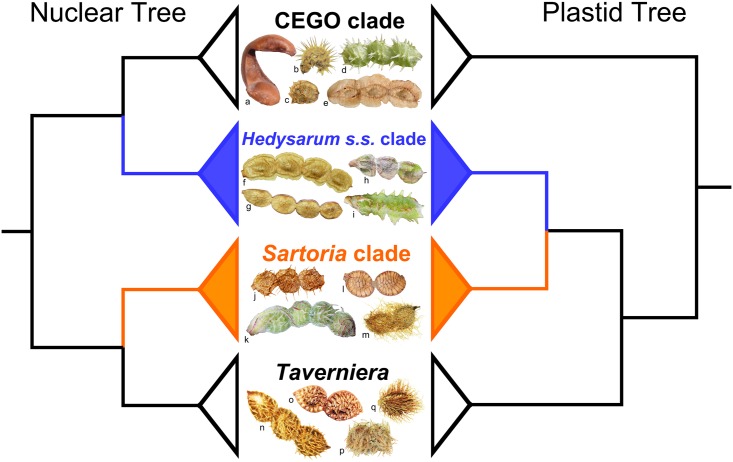
Summary of the incongruent position of the Hedysarum s.s. clade in the nuclear (left) and the plastid (right) trees, with selected legume species from each clade (middle).The legumes: a, Eversmannia subspinosa B.Fedtsch.; b, Onobrychis atropatana Boiss.; c, O. viciifolia Scop.; d, Corethrodendron multijugum (Maxim.) B.H.Choi & H.Ohashi; e, Greuteria membranacea (Coss. & Balansa) Amirahm. & Kaz.Osaloo; f, Hedysarum semenowii Regel & Herder; g, H. americanum (Michx.) Britton; h, H. kumaonense Benth. ex Baker; i, H. tibeticum (Benth.) B.H.Choi & H.Ohashi; j, H. gremiale Rollins; k, H. petrovii Yakovlev; l, H. boveanum Bunge ex Basiner; m, H. callithrix Bunge ex Boiss.; n, Taverniera diffusa (Cambess.) Thulin; o, T. glauca Edgew.; p, T. lappacea DC.; q, T. longisetosa Thulin; photoed by PLL and LD.